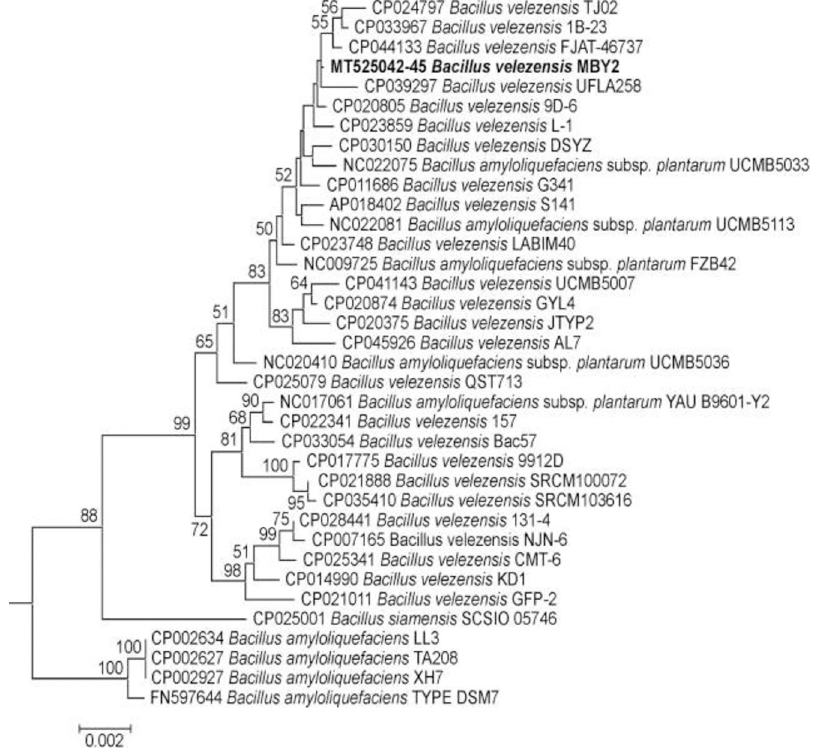
Fig 2. Maximum Likelihood (ML) phylogeny of bacteria belonging to the Operational Group B . amyloliquefaciens as reconstructed from concatenated rpoB , groEL , gyrA , and purH marker sequences. Terminal branches are labelled by GenBank accession number, genus, species and strain designations. The isolate under study is displayed in bold type. Numbers on internal branches indicate bootstrap support percentages. The size bar corresponds to 0.2% sequence divergence along horizontal branches. A concatenation of orthologous sequences from the related bacterium B . subtilis subsp. spizenii served as outgroup to root the